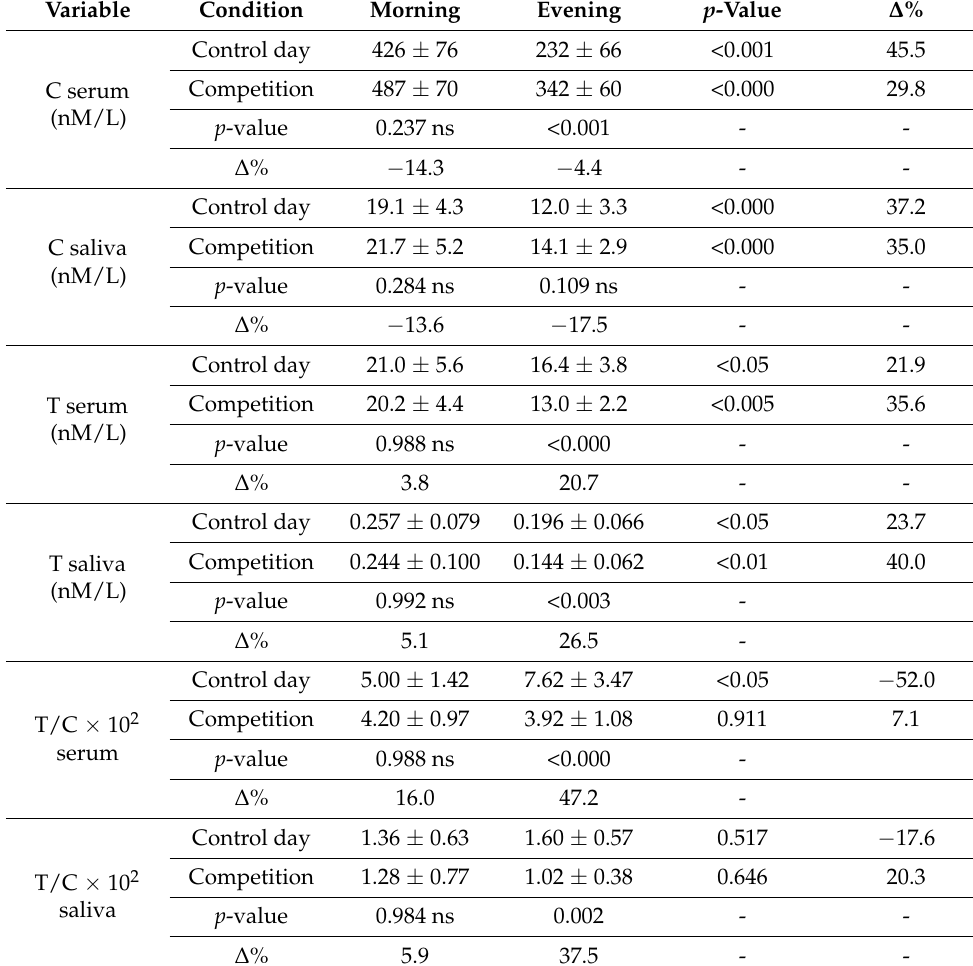
Table 1. Descriptive statistics for hormones, anabolic–catabolic values in saliva and serum, and differences between days (control day vs. competition) and time of day (morning vs. evening). Variable Condition